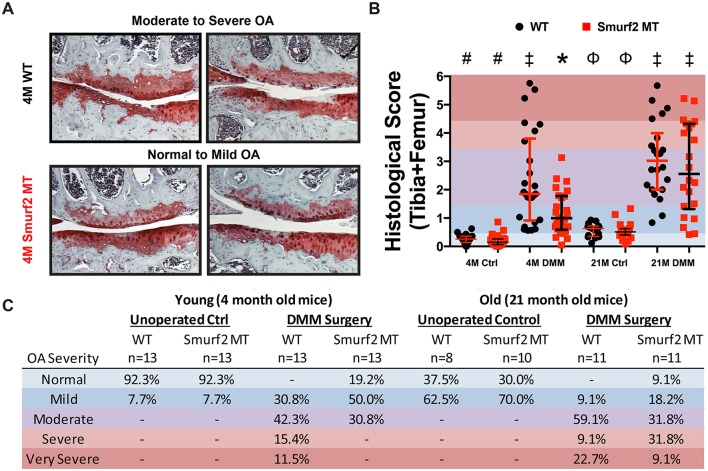
Differential severity of knee joint articular cartilage erosions in young (4 month) and old (21 ± 1.3 month) male WT and Smurf2-deficient MT mice after DMM surgery.(A) Representative images of safranin O-stained articular cartilage sections from the medial compartment of WT and MT knees 2 months post-DMM surgery. (B) Semi-quantitative histology scores of the femoral and tibial articular cartilage of DMM knees vs un-operated controls (n = 13 for 4 month; n = 11 for 21 ± 1.3 month). The average femoral and tibial articular cartilage scores for each joint were plotted separately on the same graph. Groups with the same symbol are not statistically significant (p > 0.05) based on mean ranks. (C) Distribution of DMM knee scores for WT and MT based on OA severity.